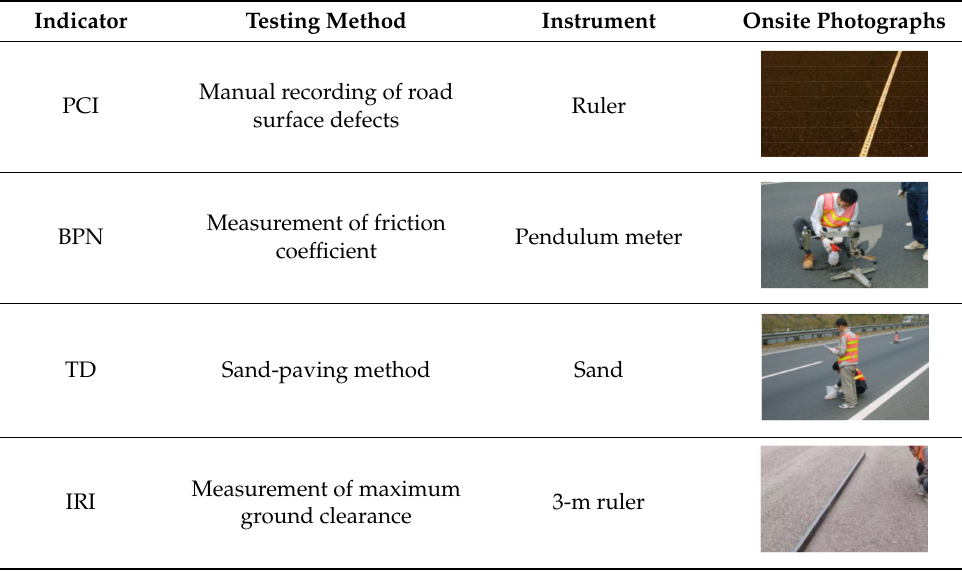
Table 6. Field test methods for the evaluation indicators.